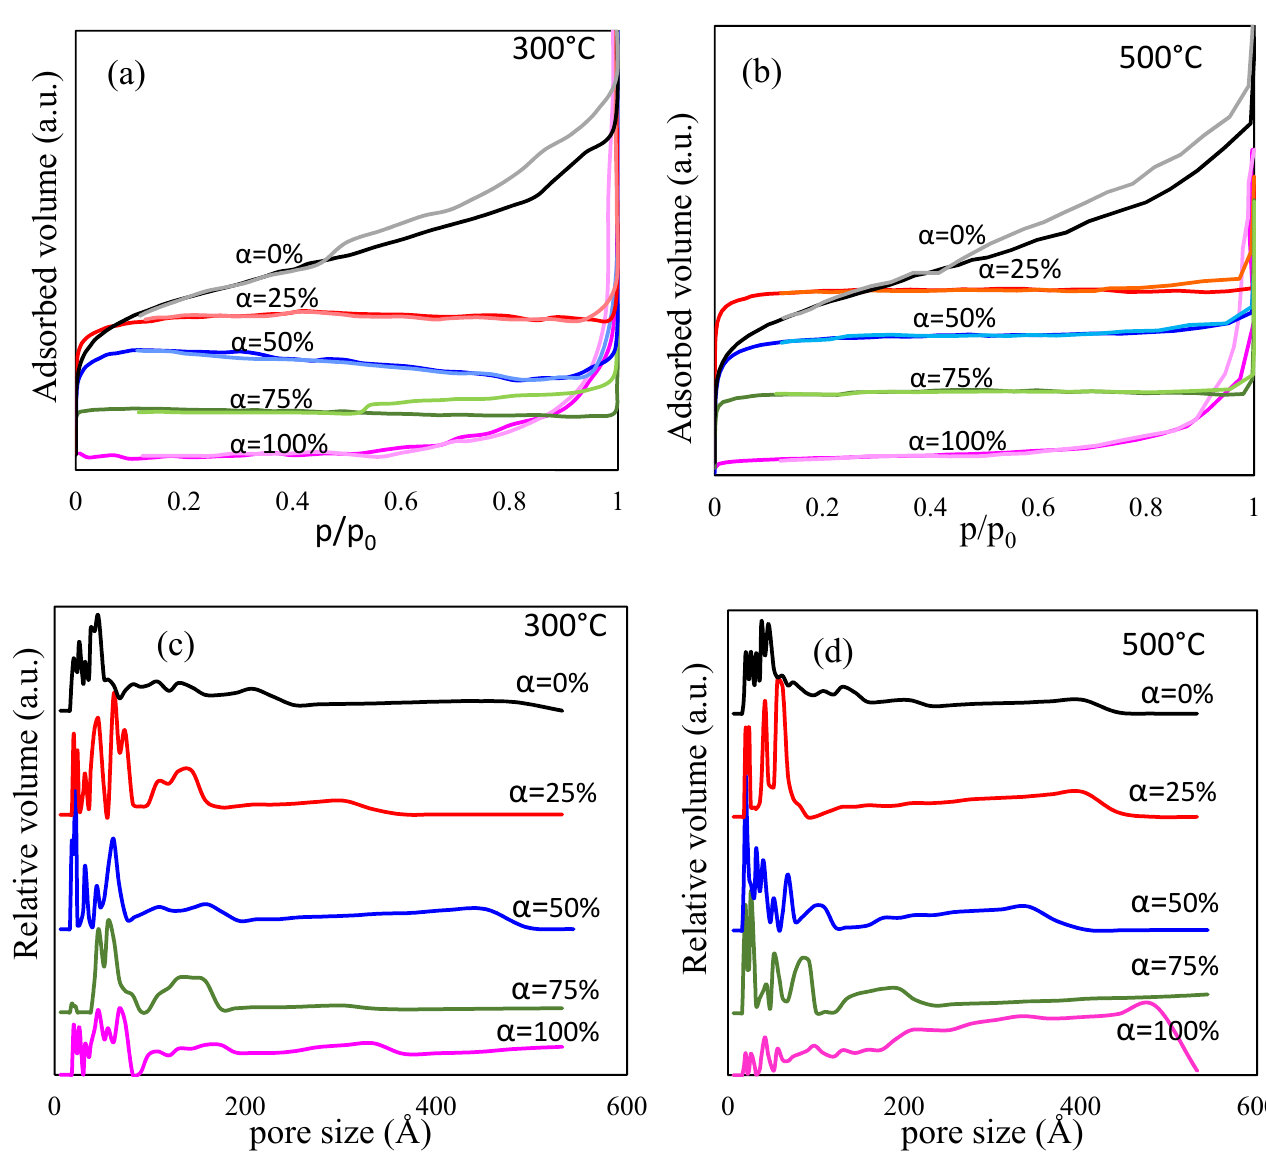
Figure 4. N 2 adsorption-desorption isotherms of (Co 0.4 Zn 0.4 Ni 0.2 Fe 2 O 4 ) α (SiO 2 ) 100 − α ( α = 0, 25, 50, 75, and 100%) samples annealed at 300 °C ( a ) and 500 °C ( b ) pore size distribution at 300 °C ( c ) and 500 °C ( d ).